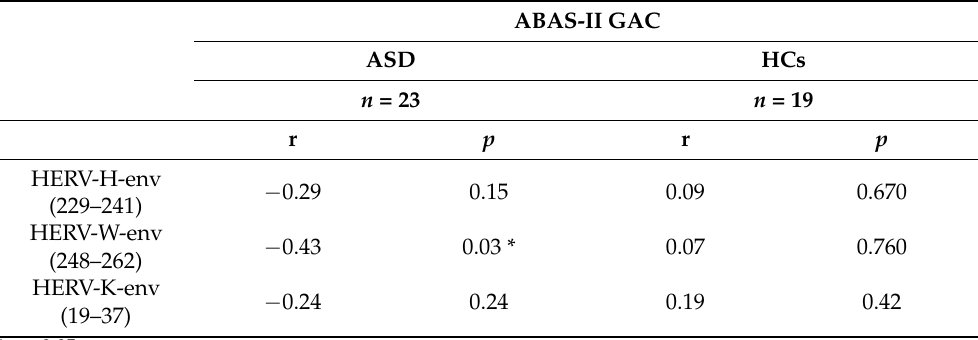
Table 8. Correlation analysis between anti-HERV-env antibody levels and adaptive abilities and social competences measured with ABAS-II (GAC index) in children with ASD and neurotypical